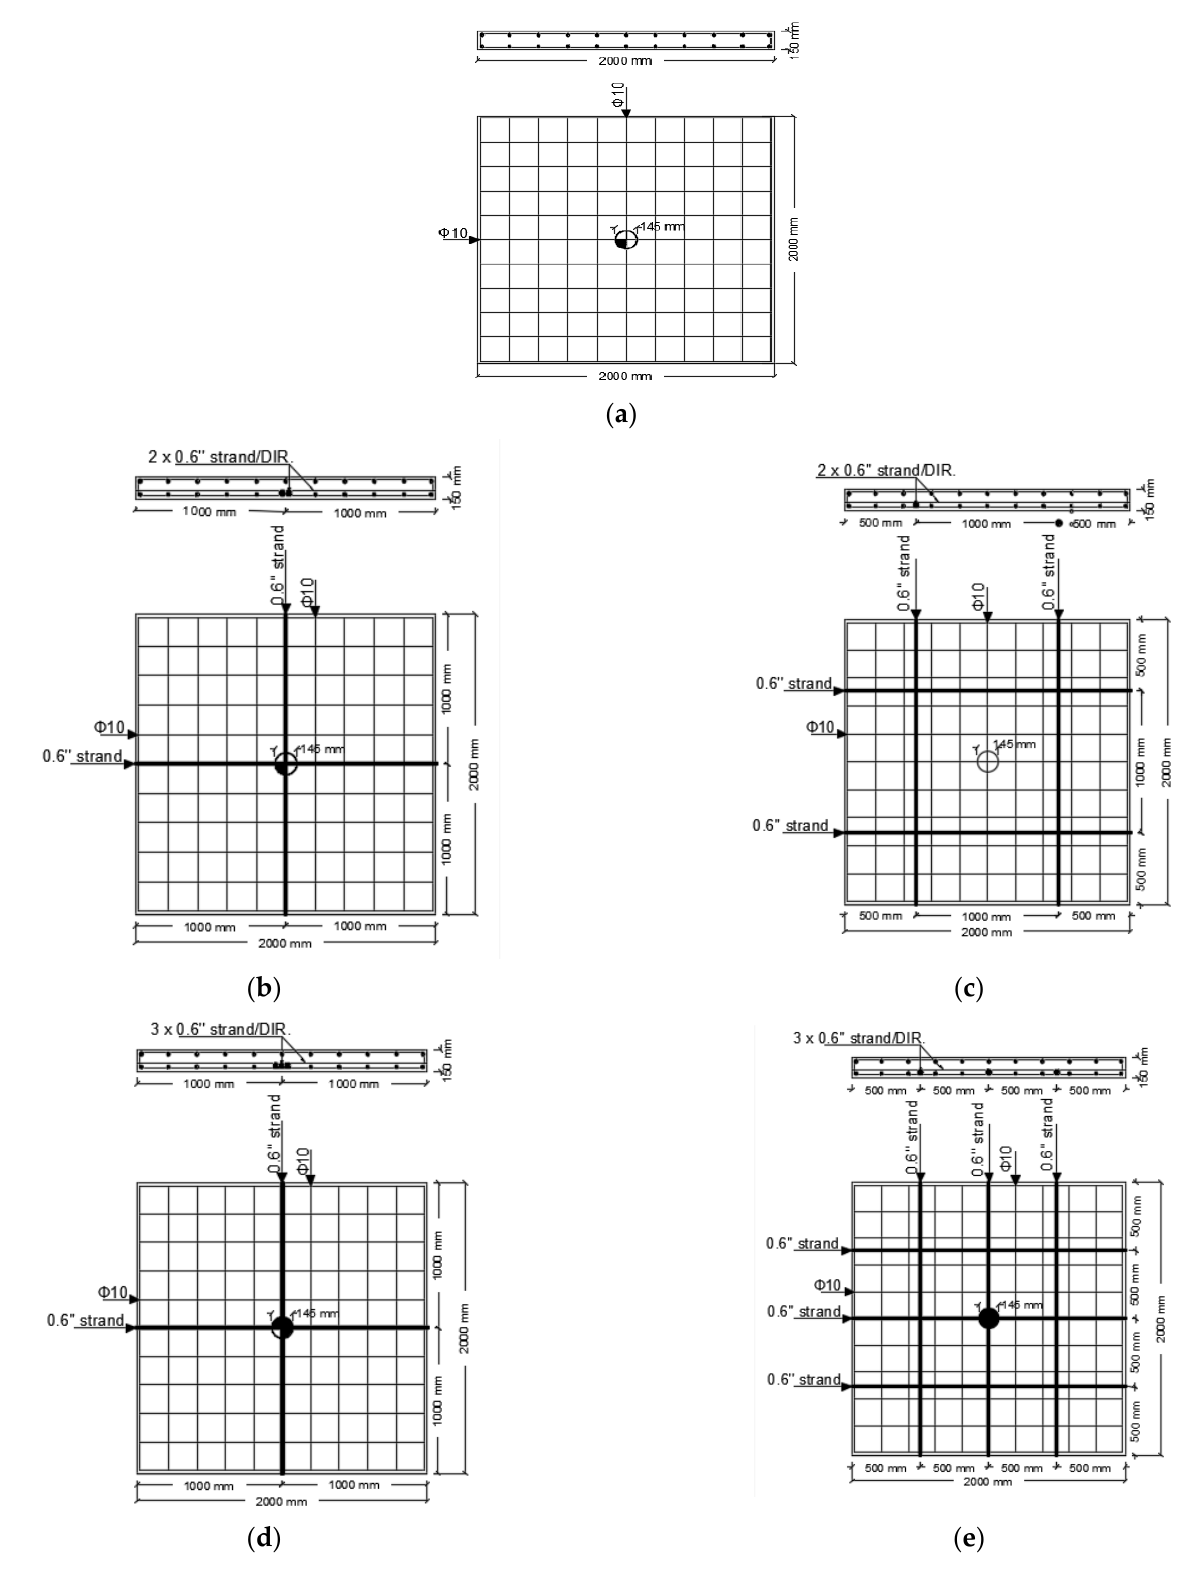
Figure 1. Details of tested specimens. ( a ) Control specimens (NF); ( b ) post-tension with two cables, central space (C2PS); ( c ) post-tension with two cables, 67 mm space (D2PS); ( d ) post-tension with three cables, central space (C3PS); and ( e ) post-tension with two cables, 500 mm space (D3PS).